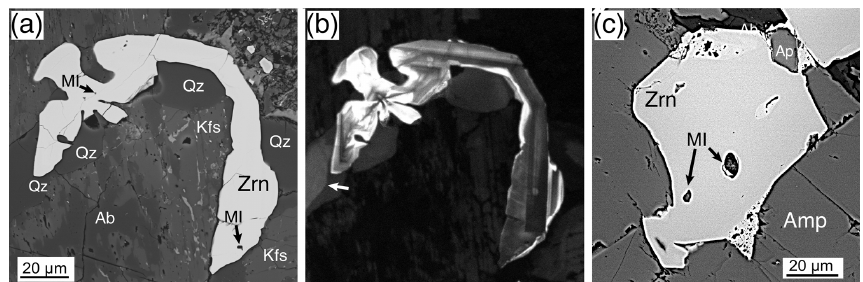
Figure 7. Late-stage magmatic zircons, BSE images except where noted. (a) A 200µm zircon (Zrn) filling an irregular space among quartz (Qz), albite (Ab), and K-feldspar (Kfs), with silicate-melt inclusions (MI). Mull, Toll Doire Granophyre, sample 44858. (b) A CL image of (a) showing typical magmatic zoning. The arrow shows the more CL-active core of a quartz grain. (c) A 100µm zircon (Zrn) filling an irregular space in amphibole (Amp), silicate-melt inclusions (MIs), and apatite (Ap). Skye, Western Red Hills Centre, Loch Ainort Granite, sample H1554.